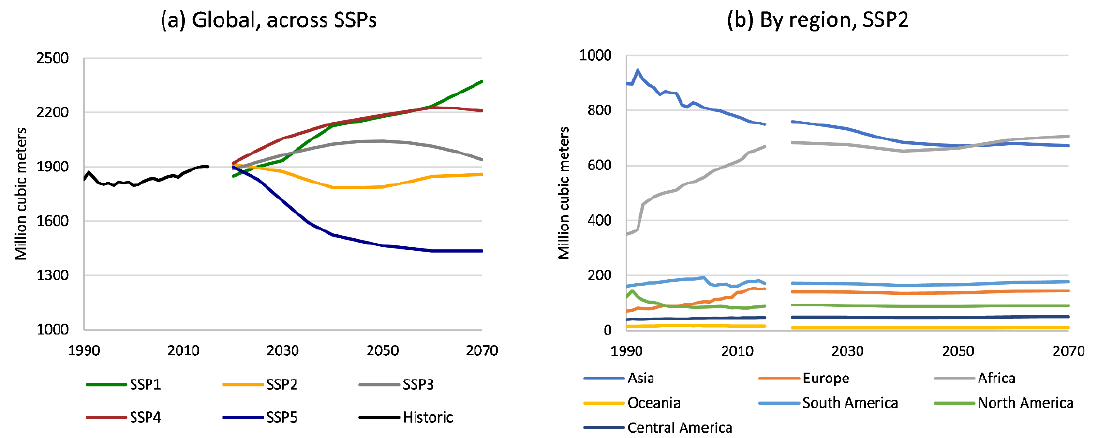
Figure 6. Global consumption of fuelwood ( a ) across SSPs and ( b ) by region within SSP2, 1990 to 2015 historic, 2020 to 2070 projections from FOROM.